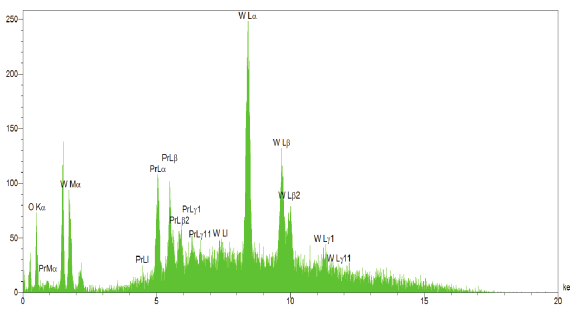
(WO ) nanoparticles by 2 4 3